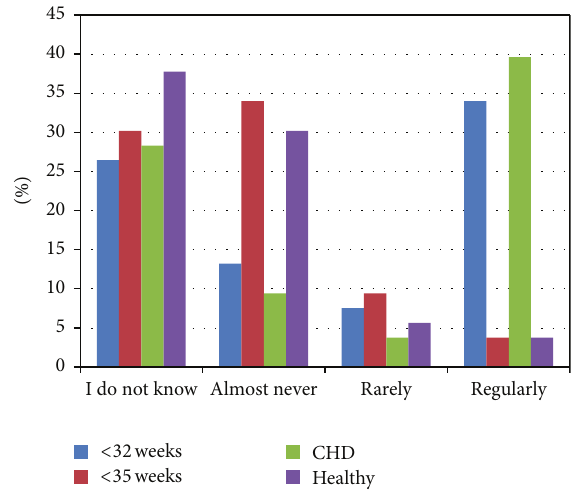
Figure 4: Answers to the following question: Can you give an estimation of the percentage of children in your country/state receiving RSV prophylaxis among the following groups? Answer options are given as follows: I do not know, almost never (0%– 5%),rarely(5%–10%),regularly( > 10%); < 32weeks:childrenwithDS born prematurely gestational age < 32 weeks (missing data: 𝑛 = 10 , 18.9%); < 35 weeks: children with DS born prematurely gestational age < 35 weeks (missingdata: 𝑛 = 12 , 22.6%), CHD:children withDS and congenital heart disease (missing data: 𝑛 = 10 , 18.9%); healthy: otherwise healthy children with DS (missing data: 𝑛 = 12 ,